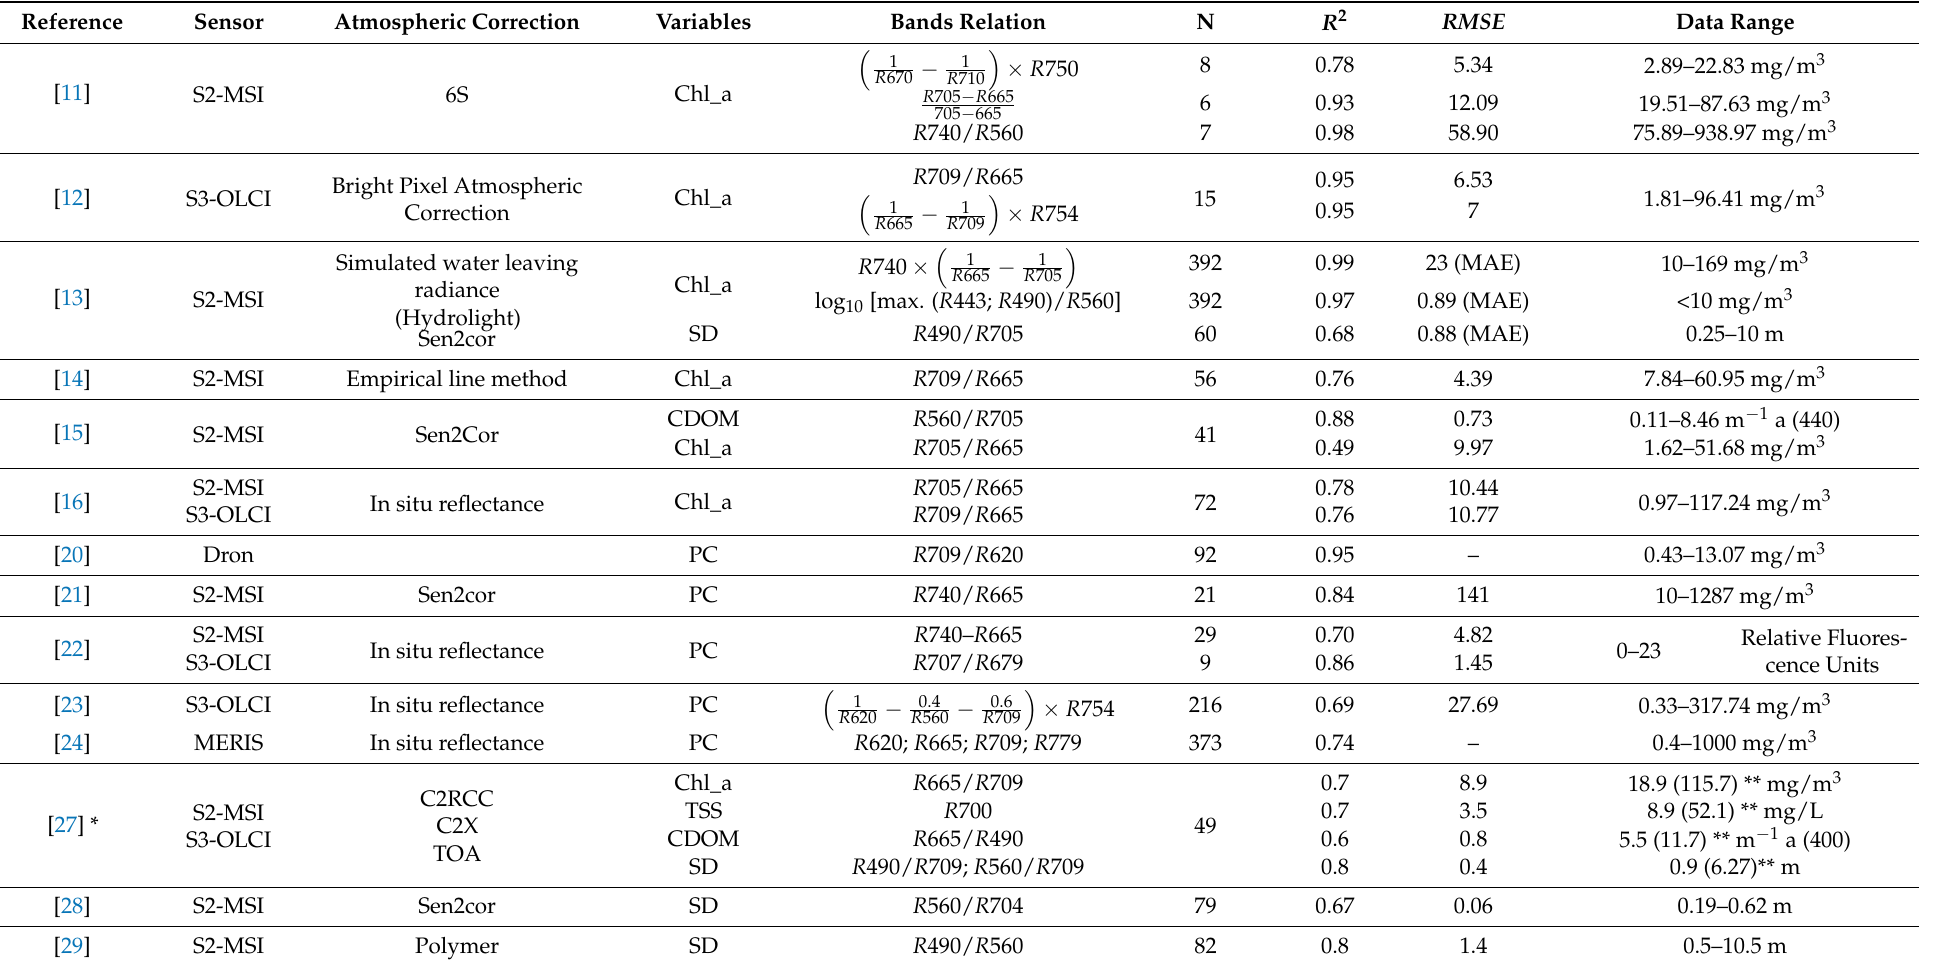
Table 2. Band math and original specified wavelengths in nm for each algorithm used to retrieve the water quality parameters. SEE (Standard error of the estimates), MAE (Mean absolute